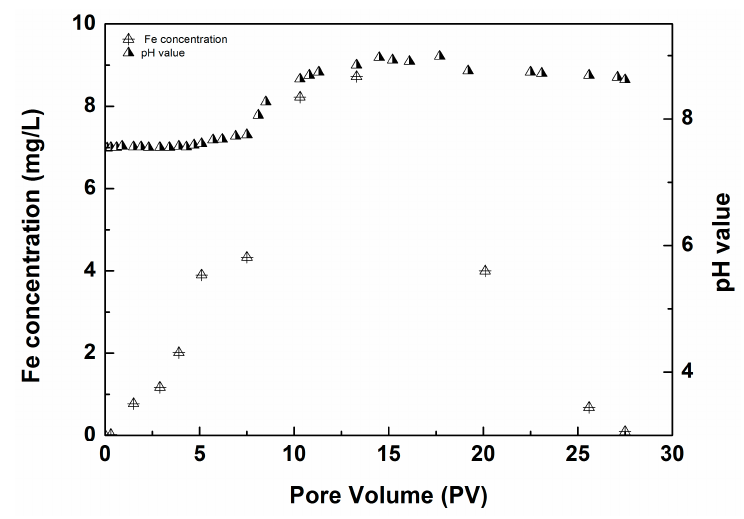
Figure 7. Variations in iron ion concentrations and pH profiles over time in the second columns of the homogeneous porous media in system A.